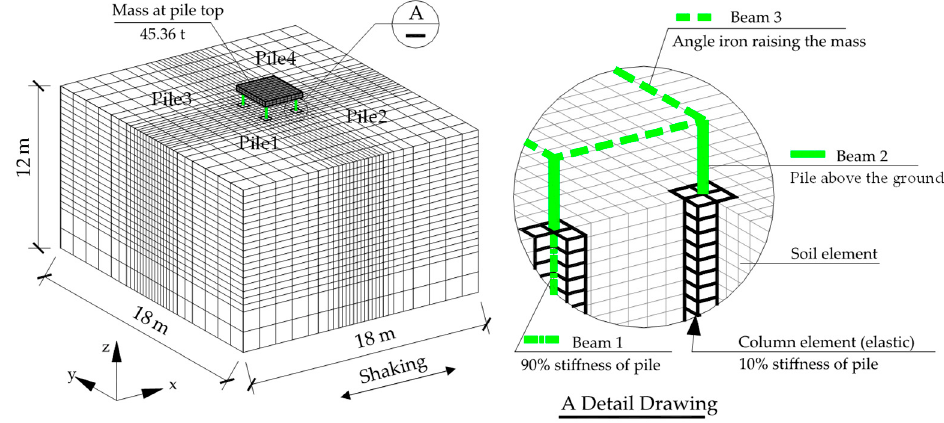
Figure 1. Finite element model of soil-pile group-superstructure system.